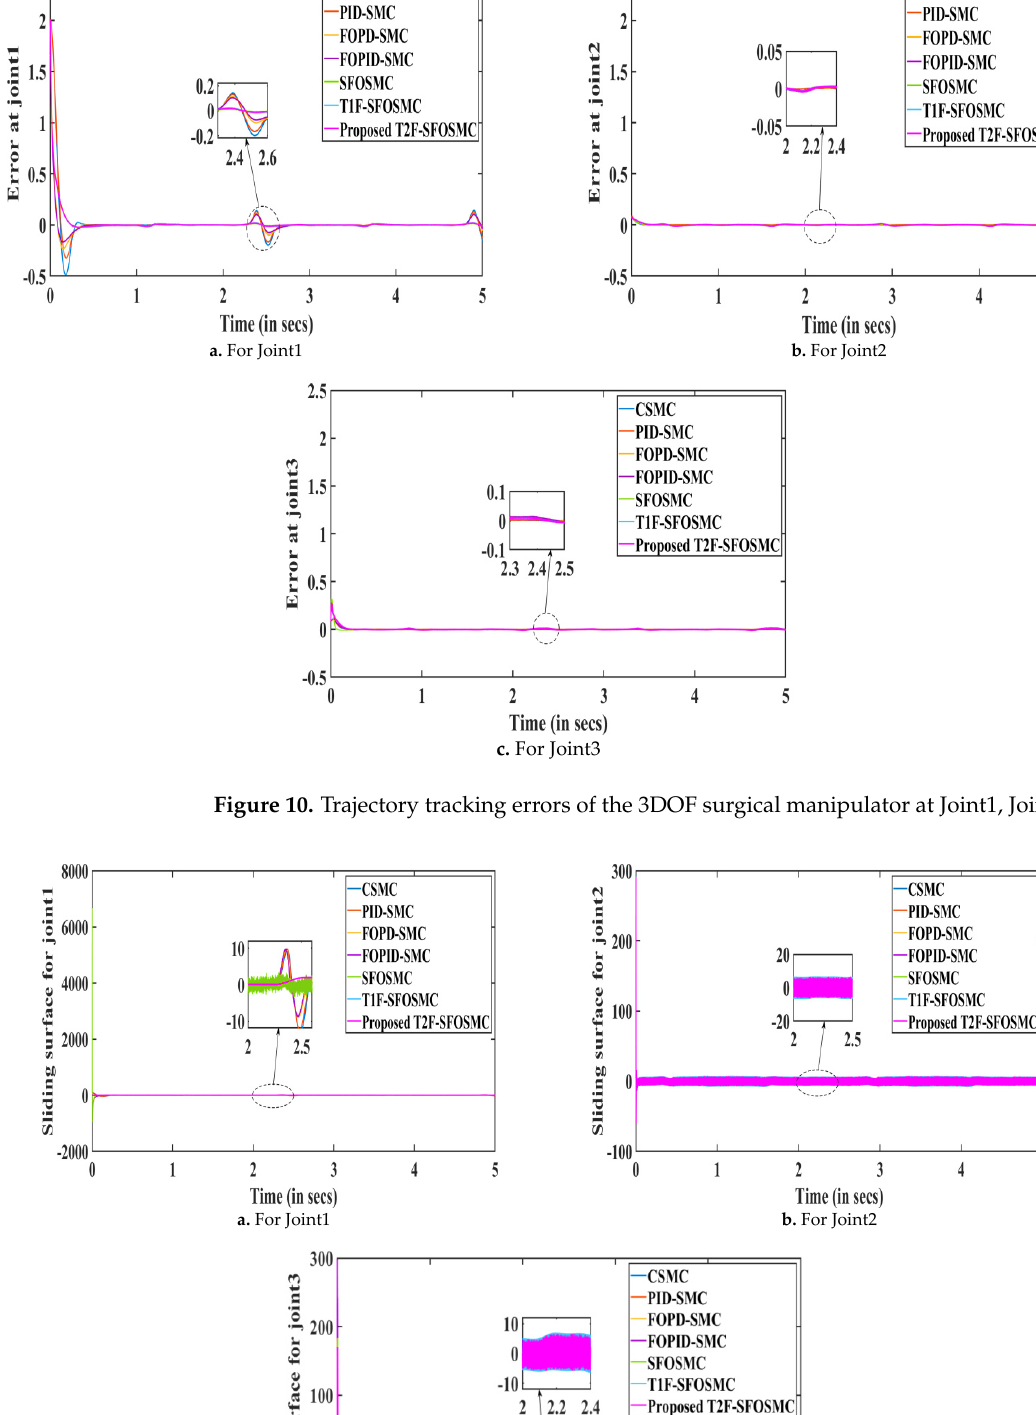
Figure 9. Trajectory tracking of the 3DOF surgical manipulator for Joint1, Joint2 and Joint3.